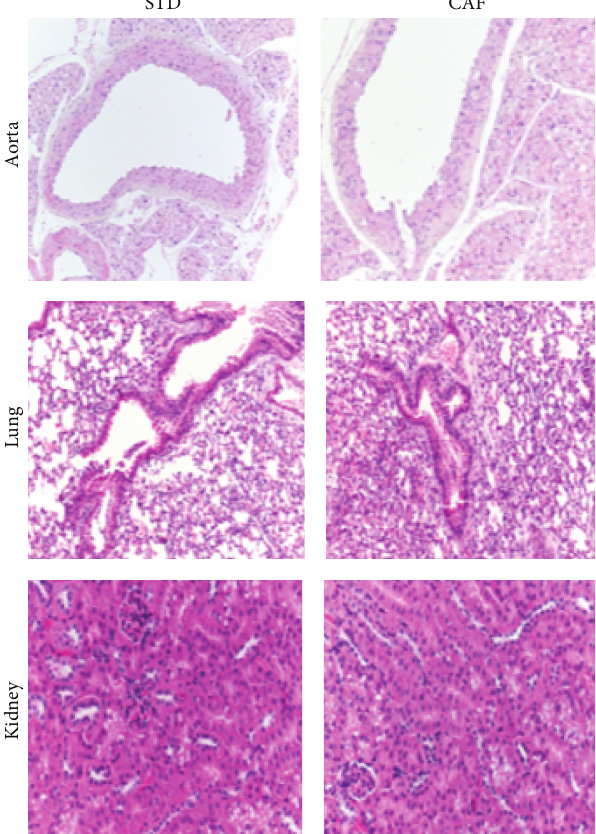
Figure 3: Histologic analysis of aorta, lung, and kidney. Hematoxylin and eosin staining of aorta, lung, and kidney sections (10x magnification) from mice fed with std or caf diet.